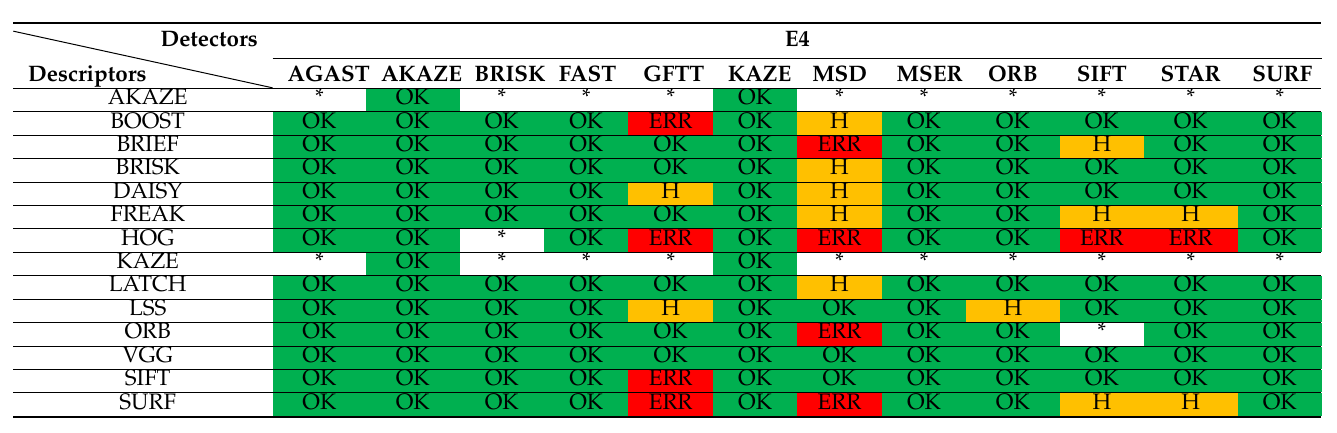
Table A4. The results of matching performed for elevation 4. The description is performed according to Equation (10), and the “*” symbol means descriptor not